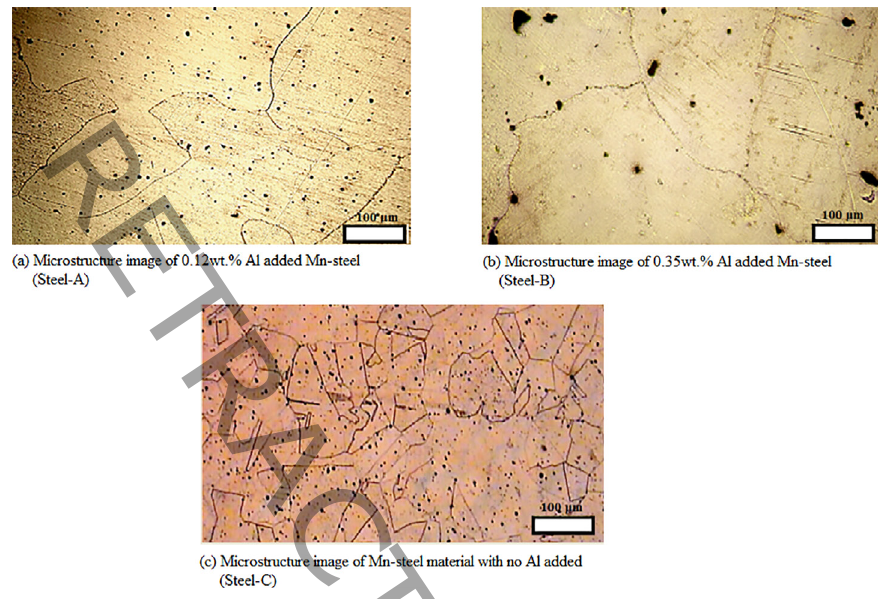
Figure 1. Microstructre of: (a) 0.12wt.% Al added Mn-steel, (b) 0.35wt.% Al added Mn-steel and (c) Mn-steel material with no Al added.